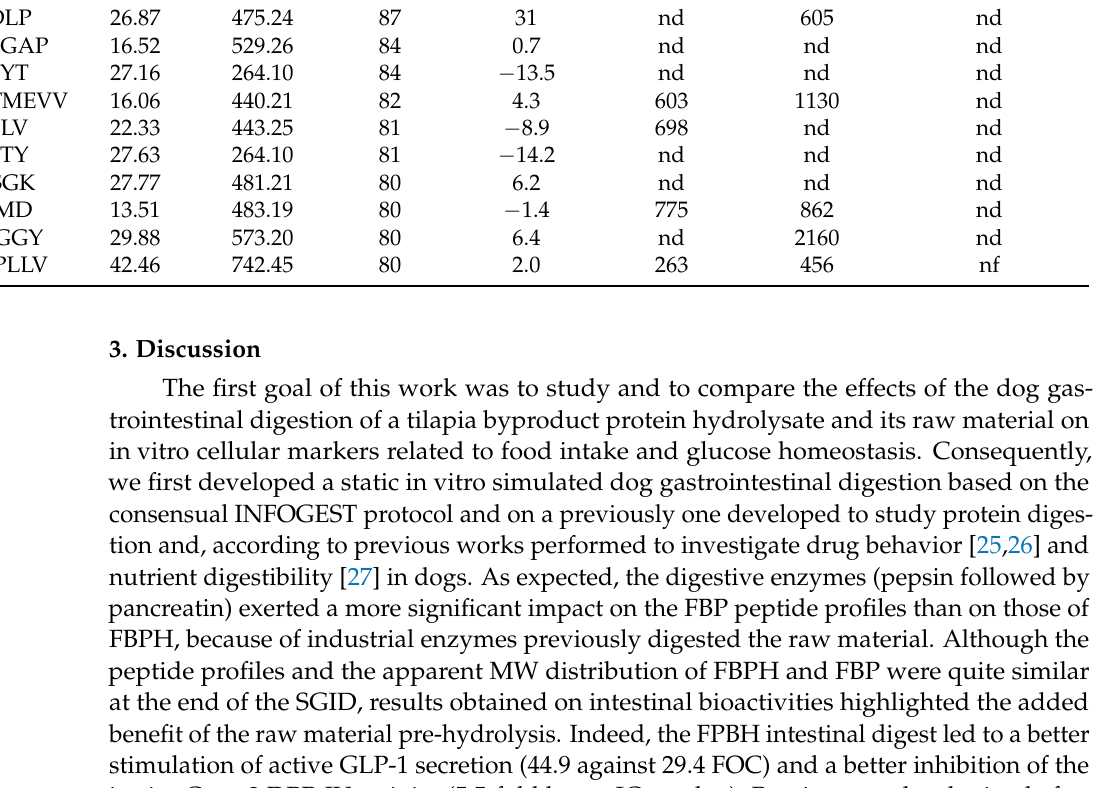
De novo CSSGK De novo